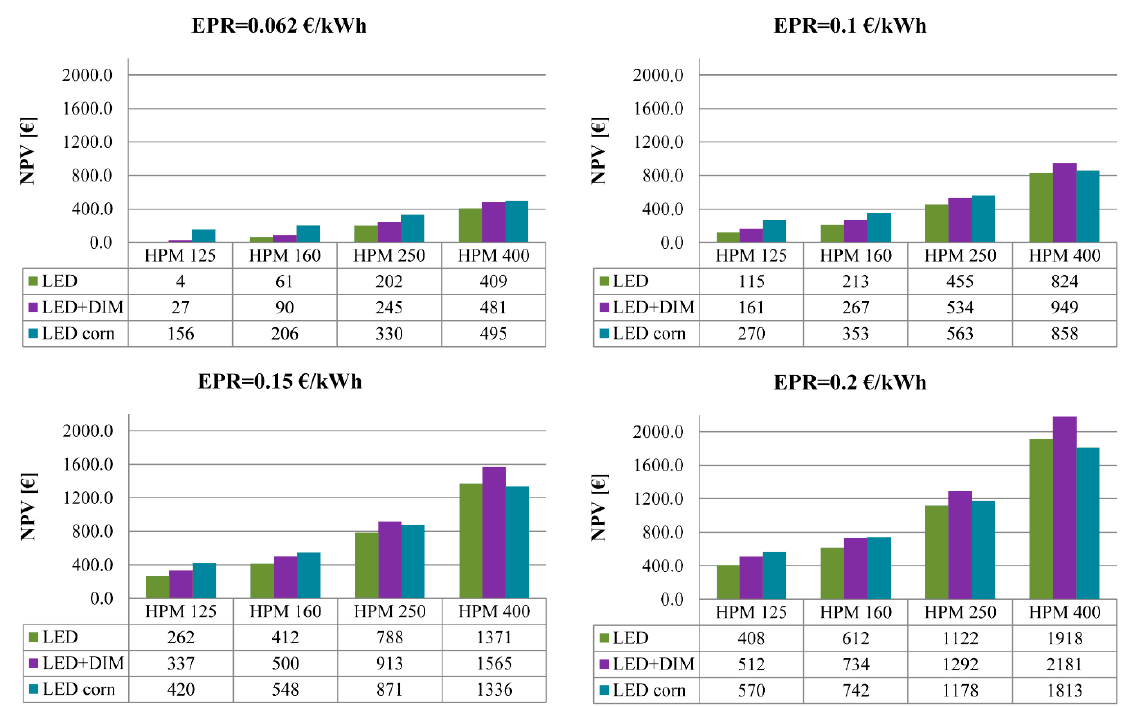
Figure 9. NPV of proposed energy efficiency measures for HPS lamps.